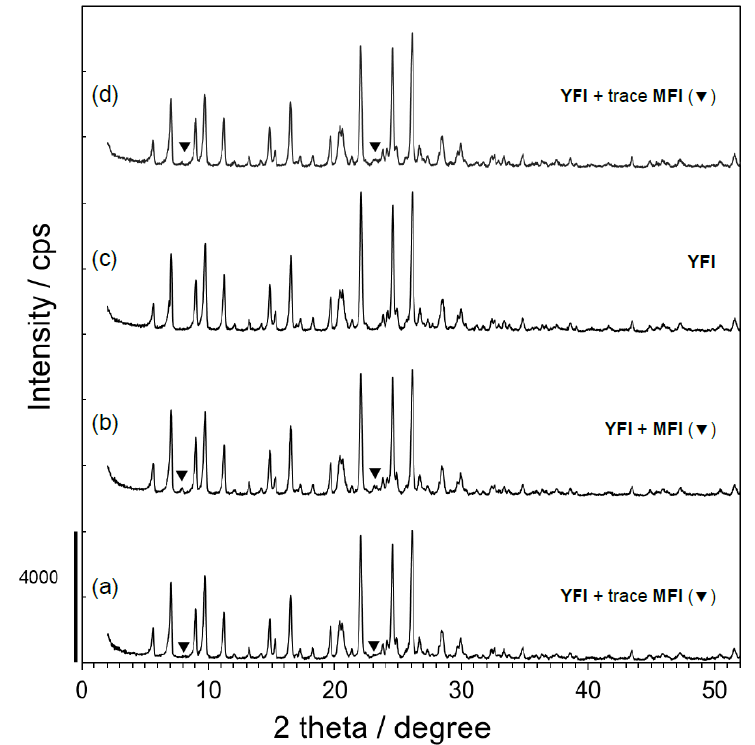
Figure 4. Powder X-ray diffraction patterns for calcined forms of (a) YFI-A, (b) YFI-B, (c) YFI-C, and (d) YFI-D crystallized while varying the rotation rate ( x , rpm) and crystallization period ( y , days), with ( x , y ) values of (a) (0, 4), (b) (0, 7), (c) (20, 4), and (d) (20, 7). The nomenclature for these samples is explained in Section 2.2. The starting molar composition was 0.265SiO 2 (from FAU ) – 0.735SiO 2 (from colloidal silica) – 0.025Al 2 O 3 (from FAU ) – 0.17Me 2 Pr 2 N + OH − – 0.15NaOH – 0.15KOH – 7.0H 2 O. The FAU was HSZ-350HUA (Lot #35UA3Y02).